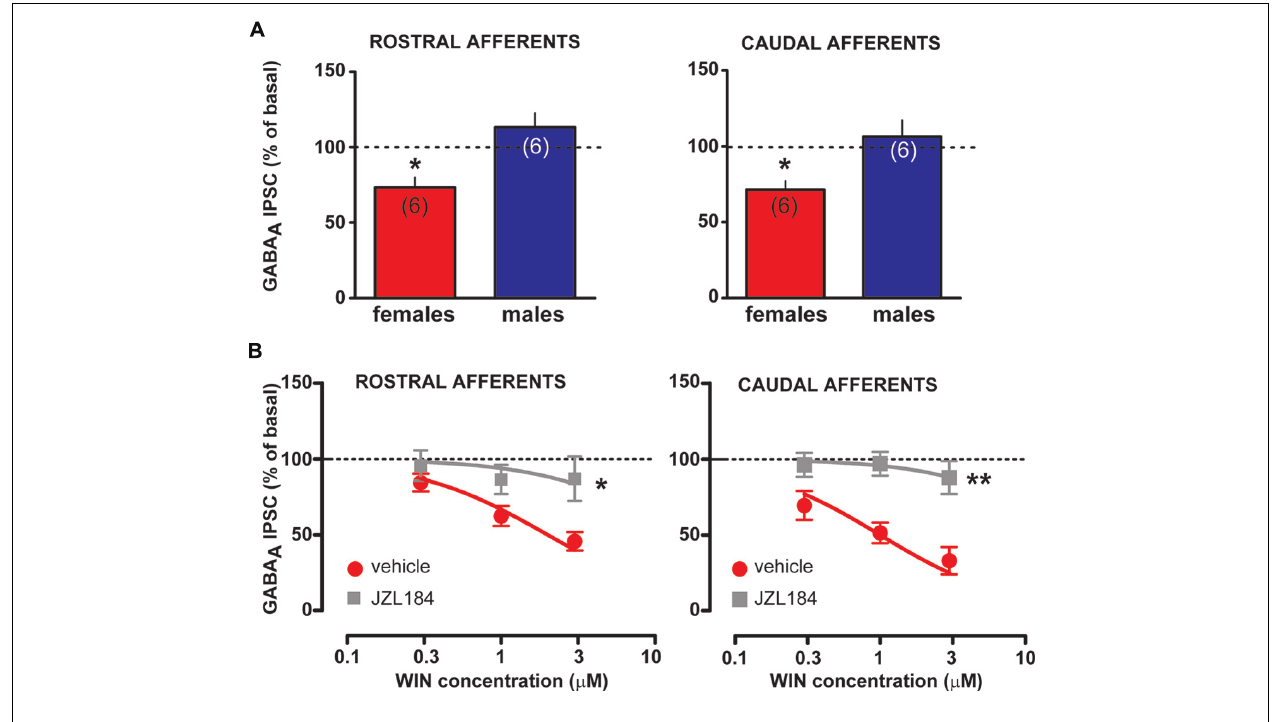
FIGURE 7 | Effect of MAGL inactivation on CB1 receptor function in female LH rats. (A) Bar graphs showing the effect of MAGL inhibitor JZL184 on the amplitude of rostral (left panel) and caudal (right panel) GABA A IPSCs in female and male LH rats is plotted. GABA A IPSCs amplitude was normalized to the averaged value (dotted line) before JZL184/vehicle bath application. (B) Dose–response curves for percentage inhibition in GABA A IPSC amplitude, which were recorded in